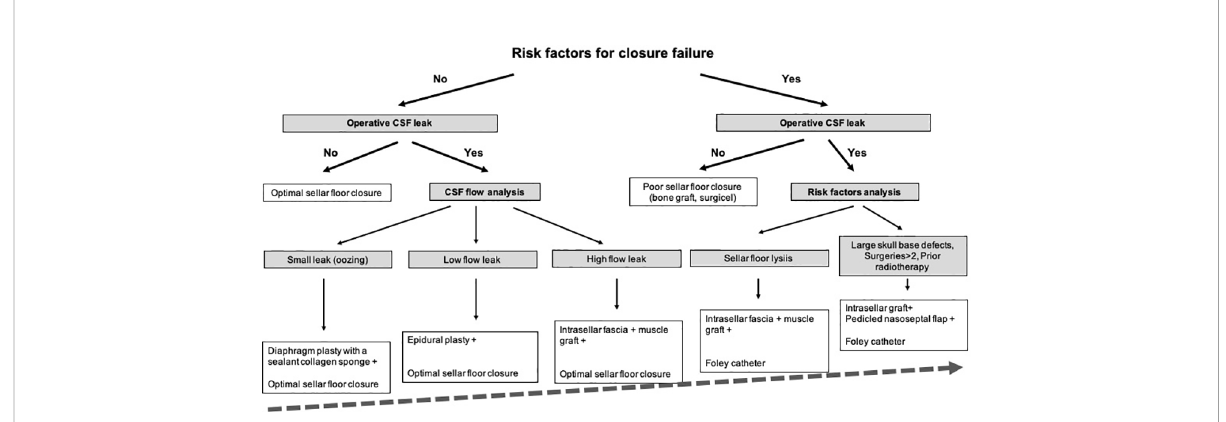
FIGURE 2 Closure strategy for pituitary surgery. Decision